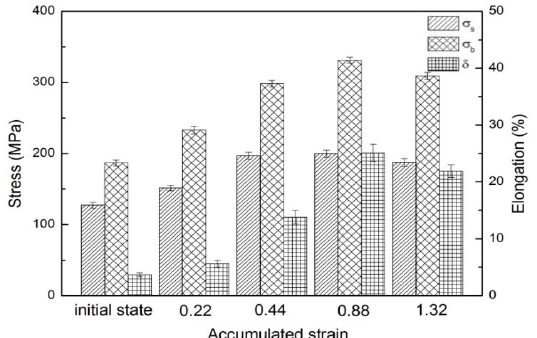
Figure 8. Mechanical properties of AZ31 alloys HSRBFed to different accumulated strains. Table 1. Mechanical properties of AZ31 alloy HSRBFed to di ff erent accumulated strains.